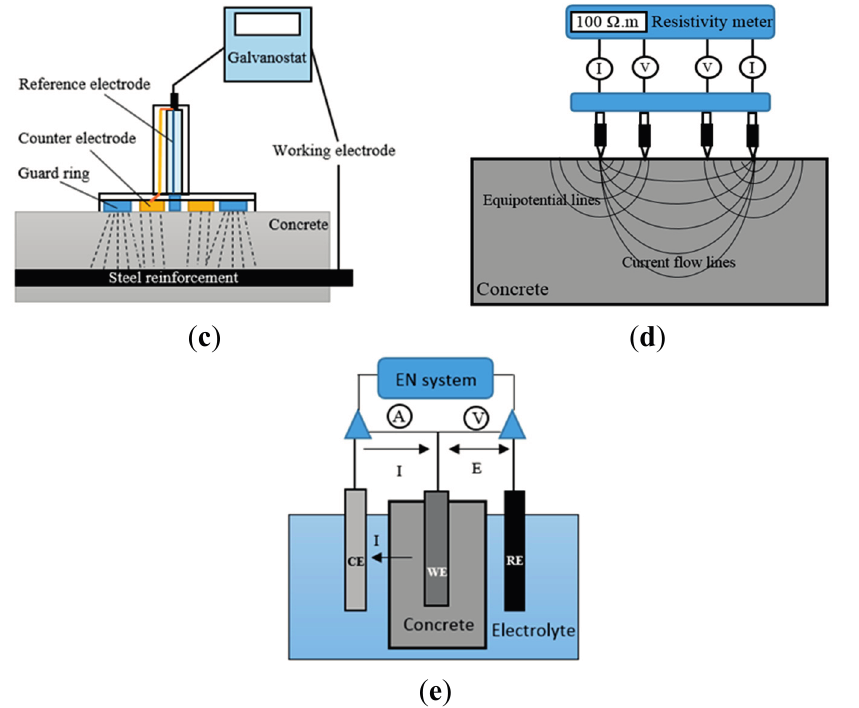
Figure 1. Principle of electrochemical methods: ( a ) open circuit potential monitoring (OCP) (Reproduced and modified from [7]); ( b ) polarization resistance (Reproduced and modified from [23]); ( c ) galvanostatic pulse method (GPM) (Reproduced and modified from [37]); ( d ) resistivity method (Reproduced and modified from [36]); and ( e ) electrochemical noise (EN) (Reproduced and modified from